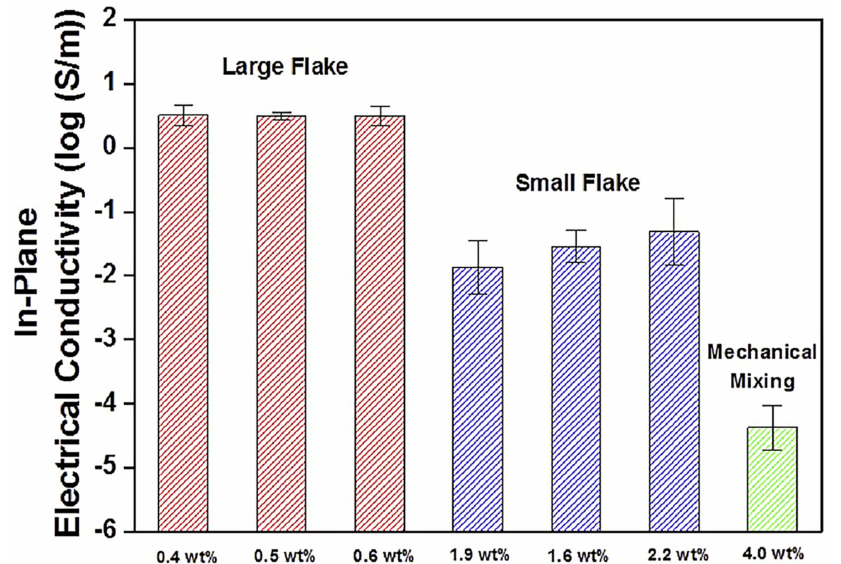
Figure 9. In-plane electrical conductivity of poly(dimethyl siloxane) nanocomposites produced from LFG and SFG, respectively. LFG = large flake graphite; SFG = small flake graphite. Reprinted with permission from Ref. [87]. 2015,